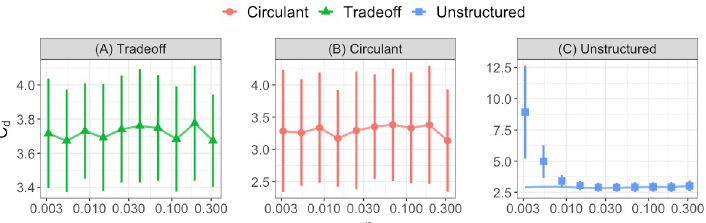
Fig 4. Unstructured networks violate theoretical stability criteria at low consumer abundances. We plot the value of the theoretical stability bound for C d averaged over 100 replicates (solid lines) as the consumer abundance n varies over three orders of magnitude for the three different matrix parameterizations (panels and colors). We also plot the average smallest C d value for which the system first becomes stable numerically (shapes) along with error bars showing one standard deviation above and below the mean. In panels (A-B), the theoretical bound accurately predicts the dependence of C d on n , while for the unstructured case (panel (C)), the theoretical predictions fail at low consumer abundance. Parameters: S = 15, r = 1, θ = 0.5, � = 0.05 and � = 1 for i 6¼ j . The off-diagonal elements of the ii ij consumption matrices are sampled from uniform distributions on [0, 2] before the parameterizations are